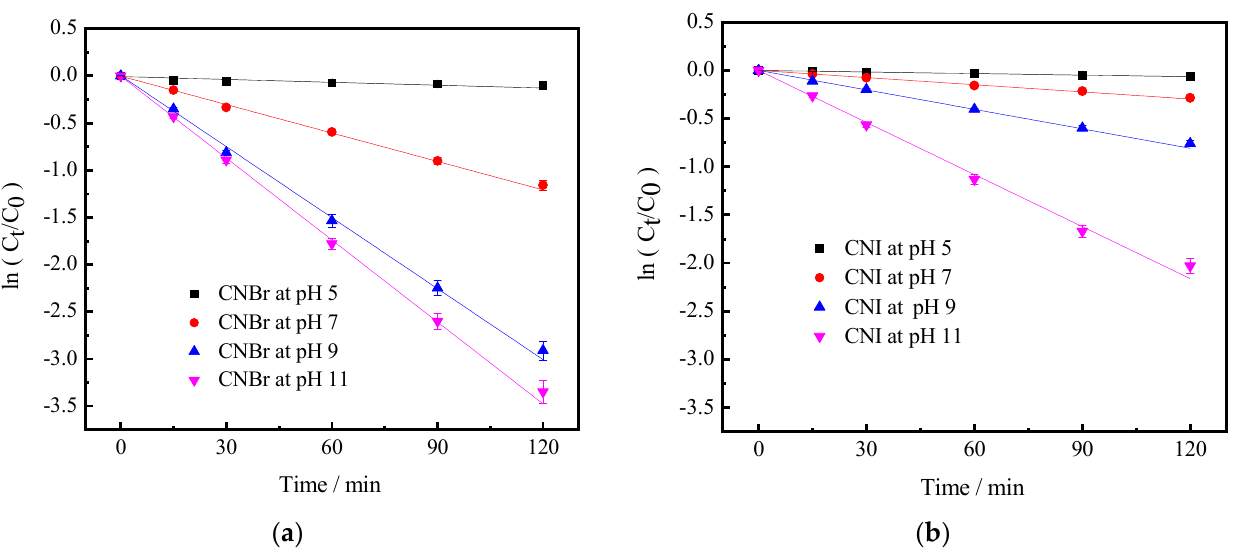
Figure 6. Stability of CNBr ( a ) and CNI ( b ) in the presence of chlorine ([CNBr] 0 = 100 μg/L, [CNI] 0 = 150 μg/L, [Cl 2 ] 0 = 1.0 mg/L).